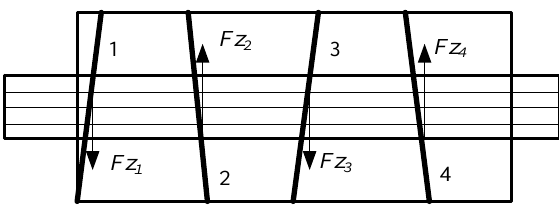
Figure 5. Unfolding axial force analysis of cutting edges of the staggered PCD end mill.